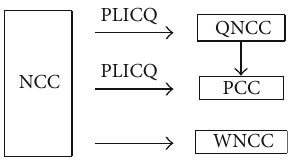
Figure 7: Relations among the four typical normal cone